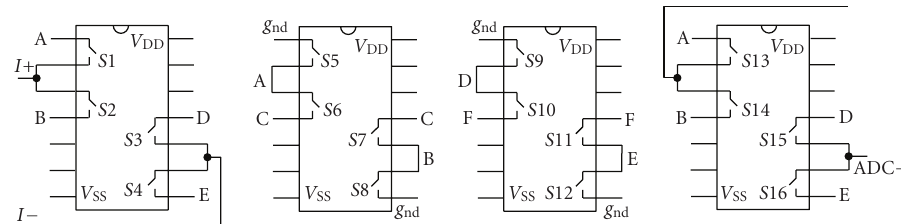
Figure 12: Pin connection of the integrator in one parallel path.